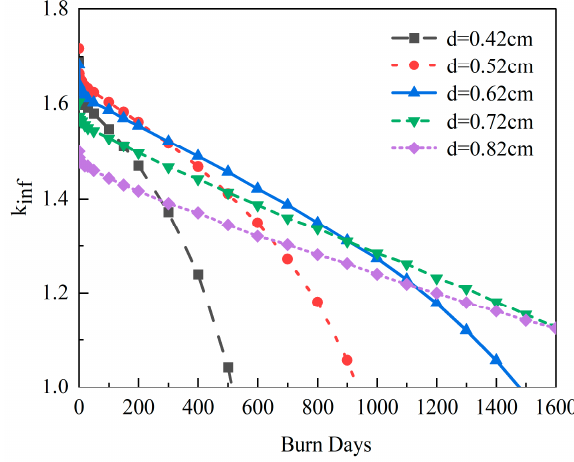
Figure 6. k inf curves with EFPD at different fuel rod diameters.